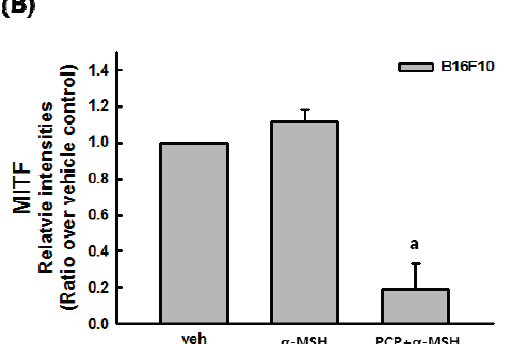
Figure 9. Transcript levels of ( A ) GPx-1 and ( B ) MITF were measured by real-time PCR. B16F10 cells were exposed to PCP (1.5 mg/mL) for 48 h following treatment with or without α -MSH for 24 h. Values are expressed as the means ± SD from three independent